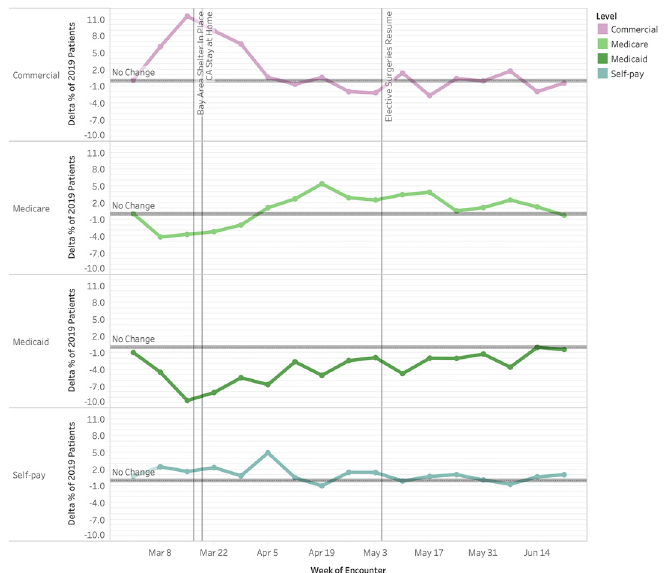
Figure 4. Change in proportion of patients by insurance status for